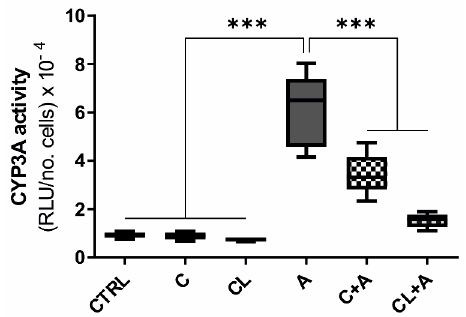
Figure 9. CYP3A enzyme activity. Box and whiskers plot reporting the CYP3A activity in the different experimental conditions. The median CYP3A activity in cells exposed to AFB1 was compared to the activity observed in all the other experimental conditions. Data are obtained from six independent cell culture experiments and expressed as relative luminescence units (RLU) normalized to the total number of alive cells. CTRL condition corresponds to cells exposed to PCB126 only. C = curcumin; CL = Curcuma longa ; A = AFB1. *** p ≤ 0.001 (one-way ANOVA, followed by Dunnett’s multicomparisons